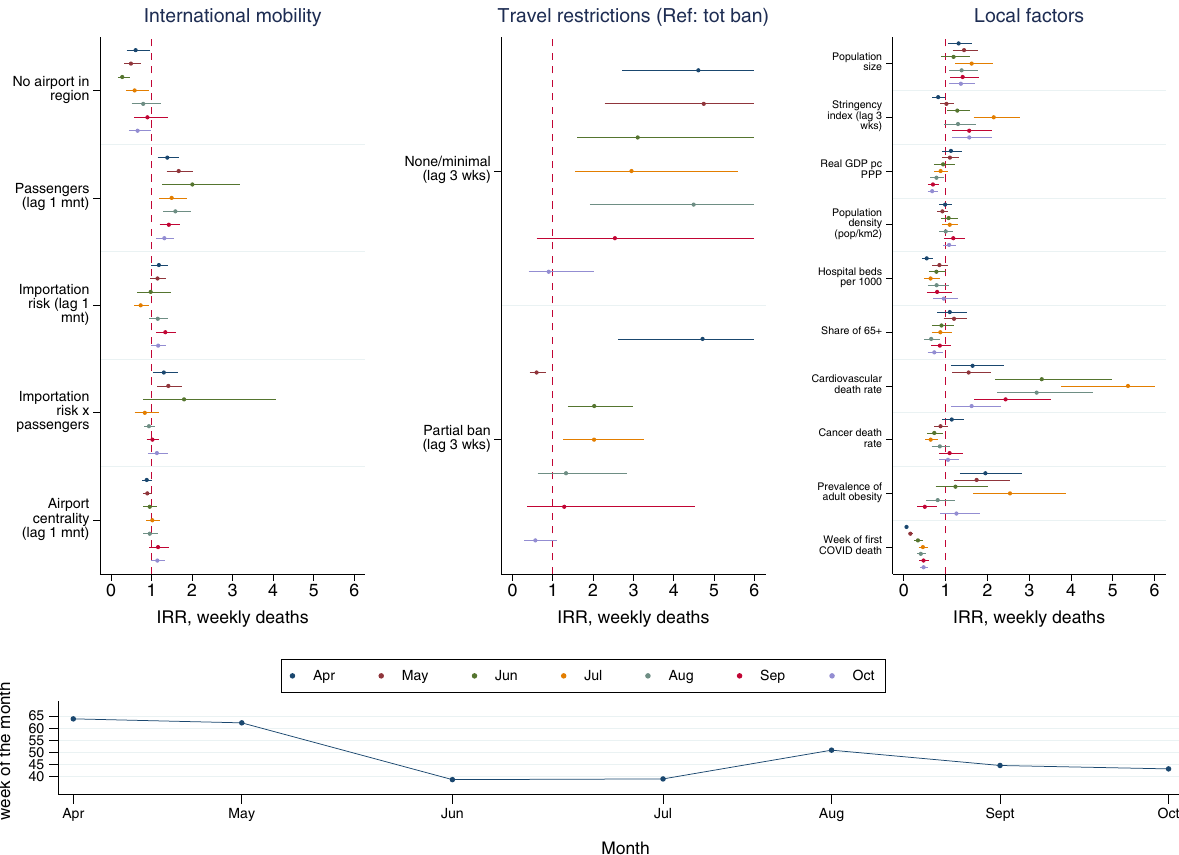
Figure 3. The impact of air passenger traffic on the severity of COVID-19 deaths (number of deaths in the first week of April–October 2020), controlling for population mixing (NPI), structural predispositions and recursive effects. Negative binomial regressions with continent fixed effects. Risk ratios and confidence intervals, For full model specifications with coefficients, see Table C2 in Supplementary Information. Source : Sub-National COVID-19 Incidence and Determinants